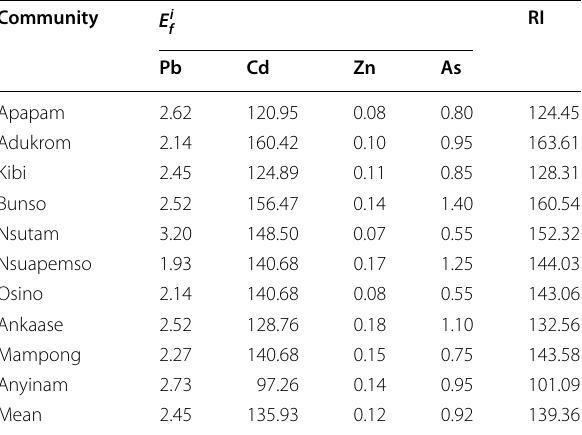
Table 8 Potential ecological risk assessment of heavy met- als in sediments samples collected from the Birim